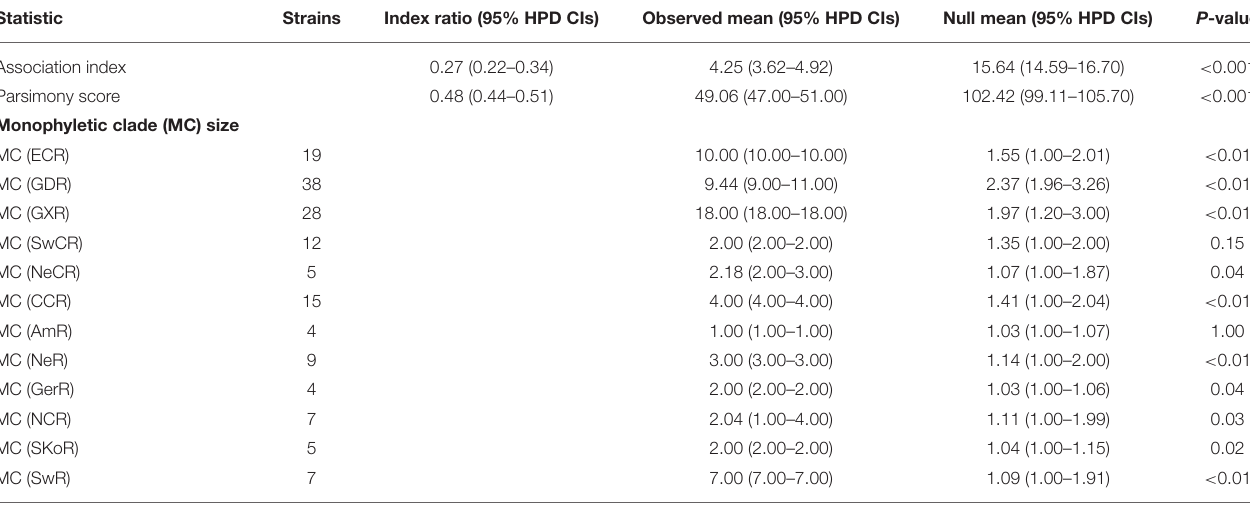
TABLE 1 | Phylogeny-trait correlation analysis for the geographic structure of APPV using BaTS